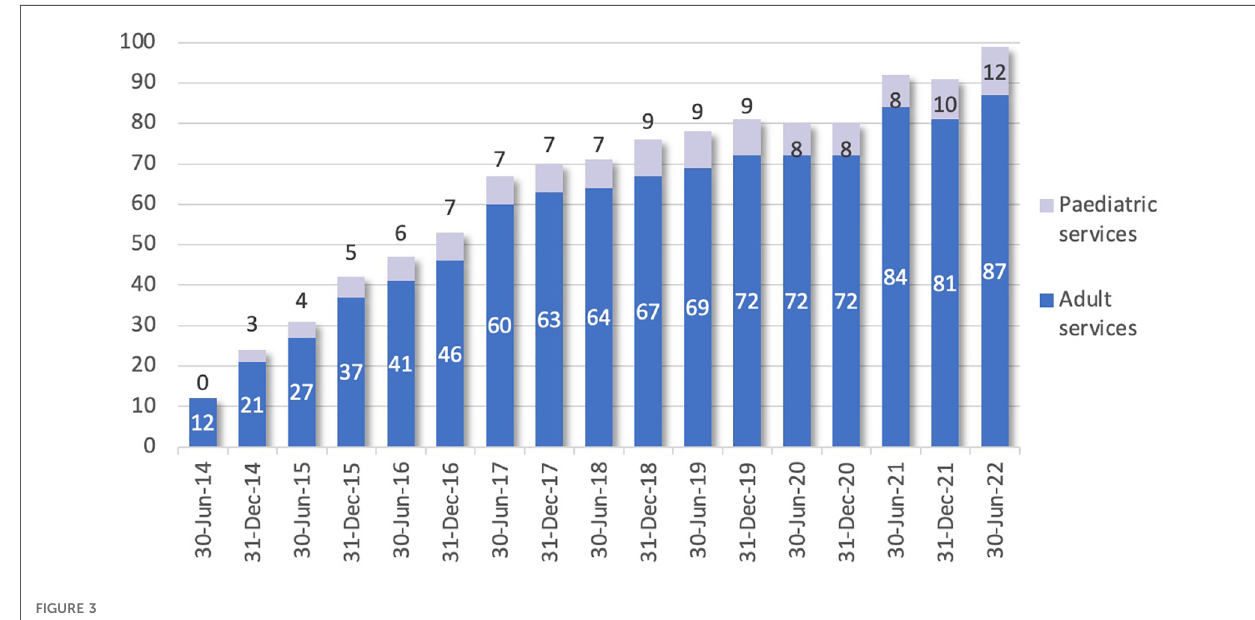
FIGURE 3 Number of data submitting services since ePPOC